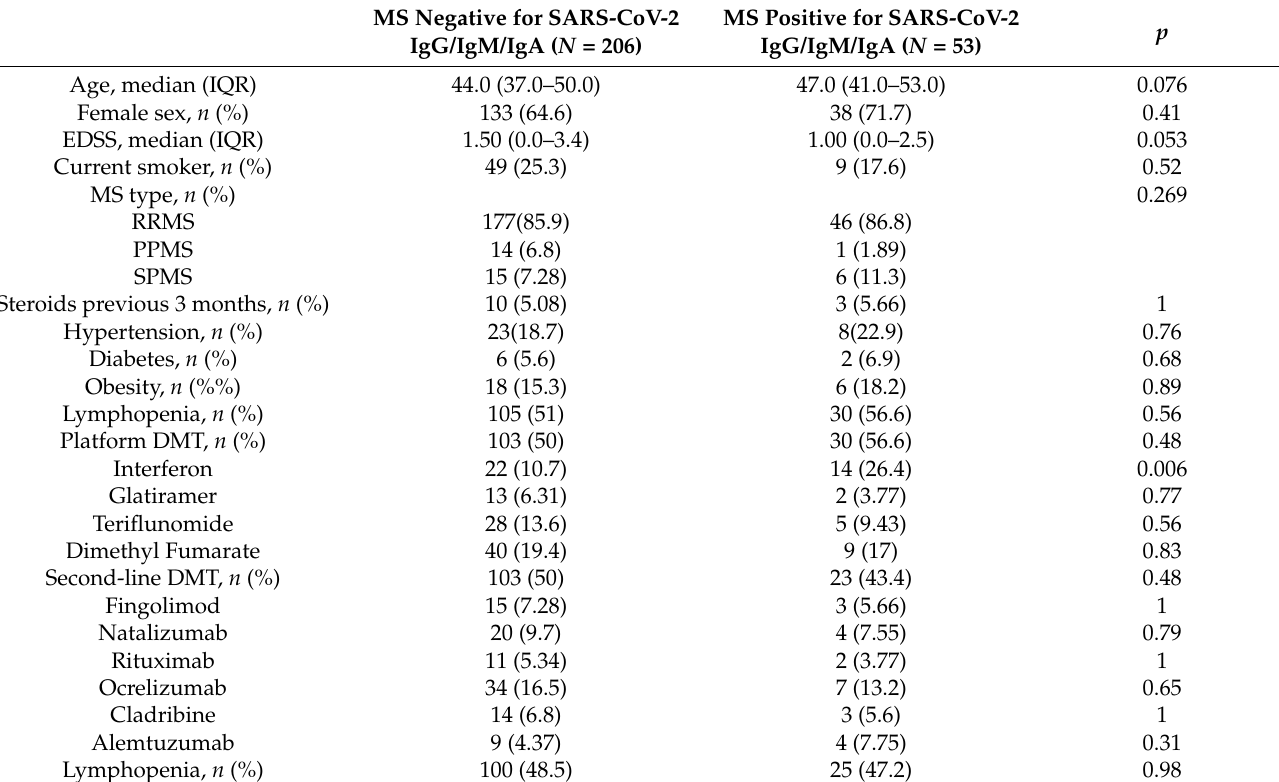
Table 2. Demographics, clinical characteristics, DMT, and COVID-19 immune